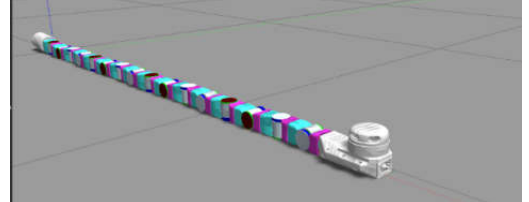
Figure 7. Snake robot simulation model.